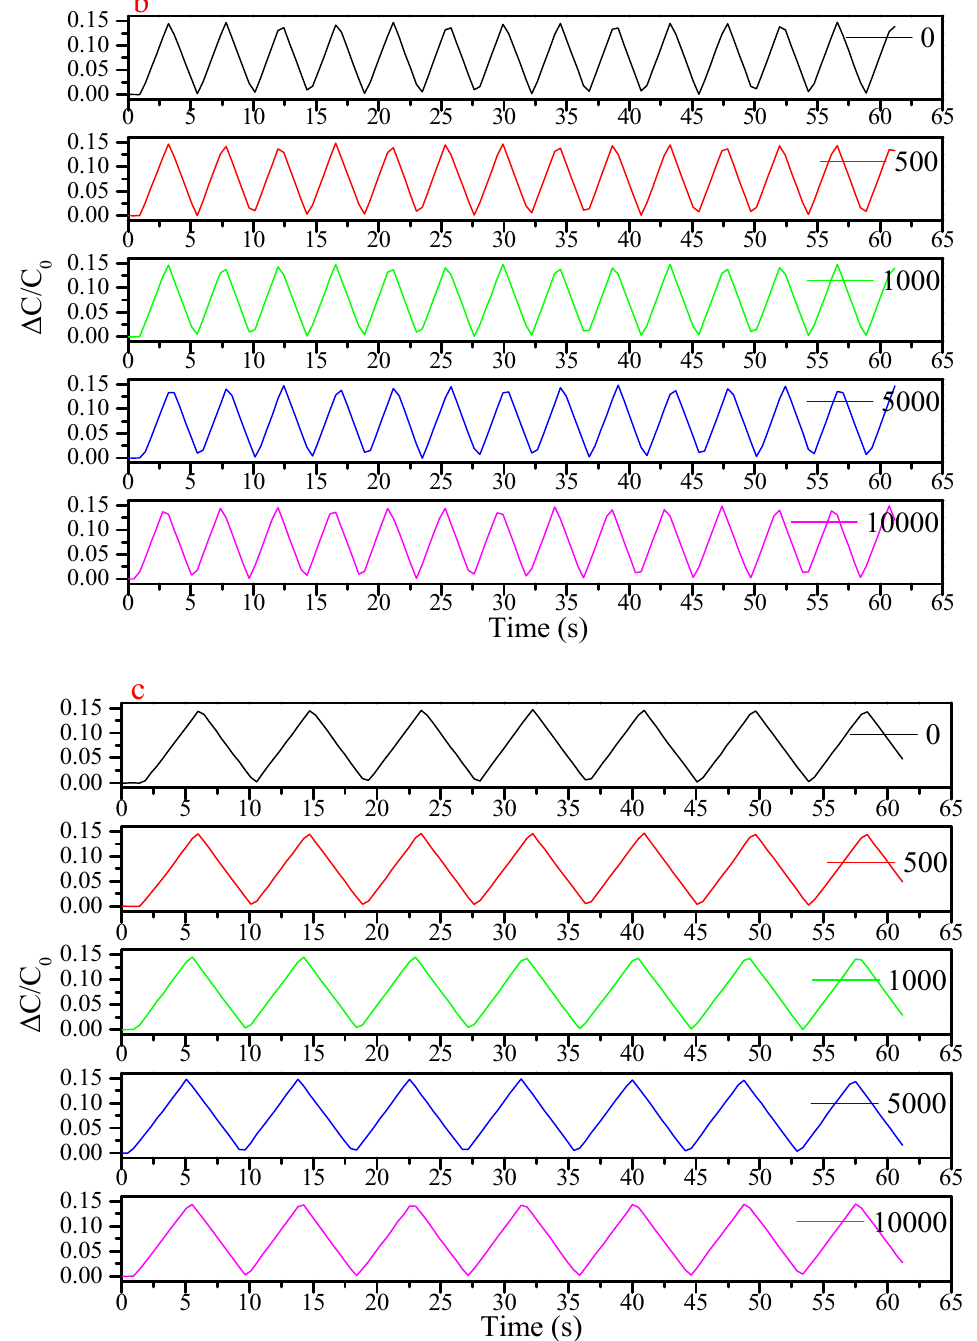
Figure A3. ( a ) Sensor record at the frequency of 0.5 Hz with 20% elongation at different times of the durability test; ( b ) at the frequency of 0.2 Hz with 20% elongation; ( c ) at the frequency of 0.1 Hz with 20% elongation.